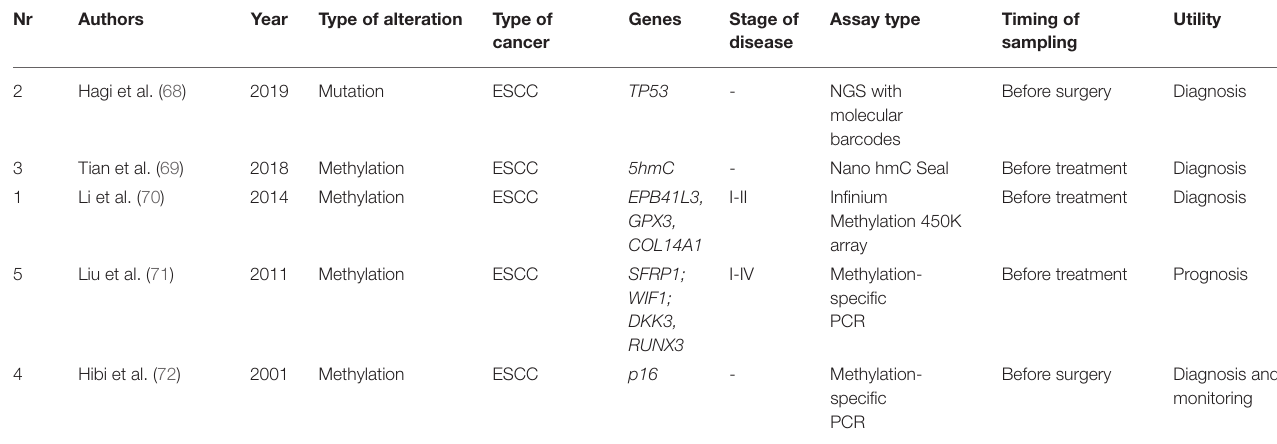
TABLE 3 | Significant studies on cell-free DNA in ESCC—clinical